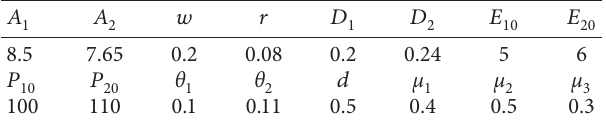
Table 1: The parameters used in the numerical example.